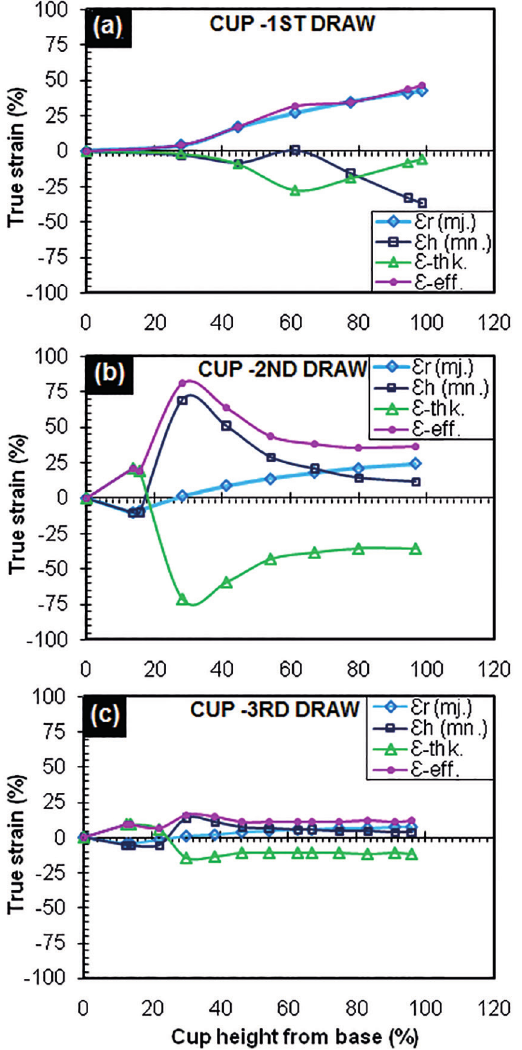
Figure 9: Stage wise graphical showing of strain distribution profiles of cups, a) 1 st draw, b) 2 nd draw, and b) 3 rd